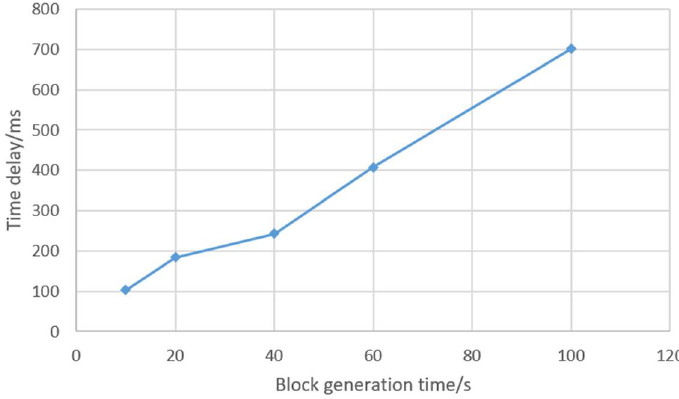
Figure 9. Time delay of the IIoT blockchain network.